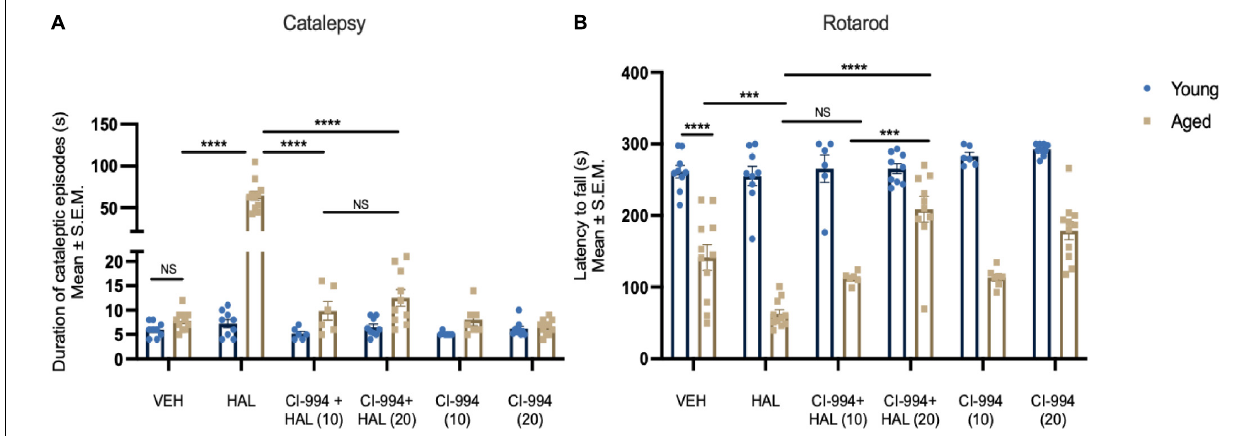
FIGURE 1 | CI-994 mitigates HAL-induced motor side effects in aged mice. (A) Aged but not young mice increased cataleptic episodes after HAL administration. CI-994 at 10 and 20 mg/kg could efficiently blocked HAL-induced (10 mg/kg CI-994 + HAL vs HAL aged mice, p < 0.0001; 20 mg/kg CI-994 + HAL vs HAL aged mice, p < 0.0001) cataleptic behavior. However, there was no significant difference between 10 mg/kg CI-994 + HAL and 20 mg/kg CI-994 + HAL groups ( p = 0.9997). CI-994 at 10 or 20 mg/kg alone do not affect cataleptic behavior (B) . Aged mice displayed an impairment of motor coordination tested by the Rotarod test (young VEH vs aged-VEH, p < 0.0001). HAL exacerbated a motor coordination deficit in aged mice (aged VEH vs aged HAL, p = 0.0001). CI-994 at 20 mg/kg but not 10 mg/kg significantly improve motor coordination in aged mice (10 mg/kg CI-994 + HAL vs HAL p = 0.2318; 20 mg/kg CI-994 + HAL vs HAL p < 0.0001). Additionally, a significant difference between 10 mg/kg CI-994 + HAL and 20 mg/kg CI-994 + HAL groups ( p = 0.0001). Data represent mean ± SEM ( n = 6–11/group). *** p < 0.001, **** p < 0.0001, NS, not significant.